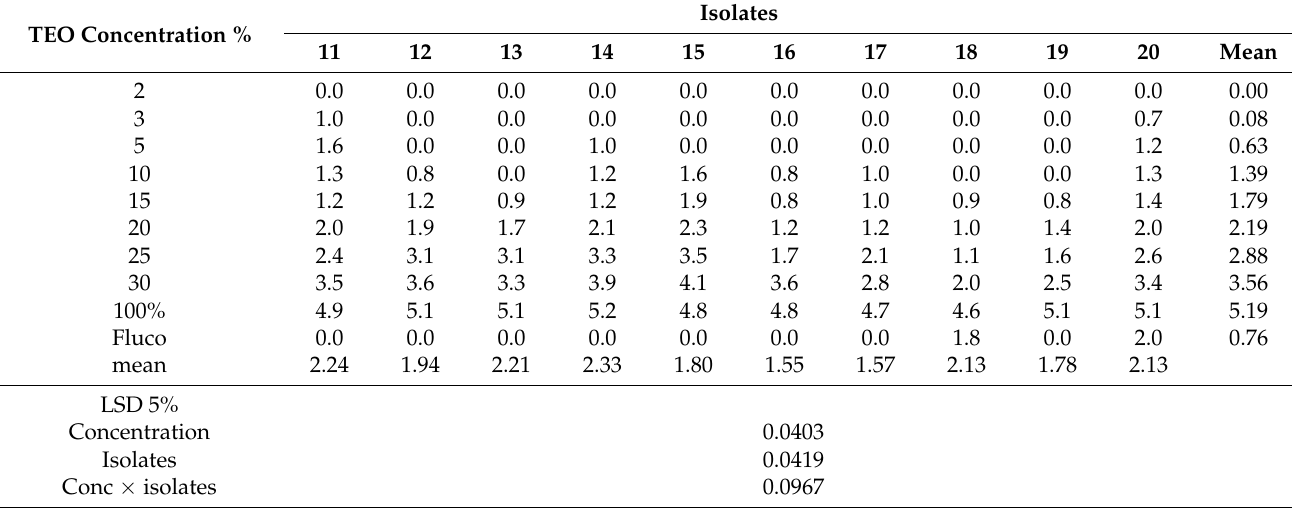
Table 4. Zone of inhibition (cm) of C. albicans isolates from blood at different concentrations of thyme essential oil (TEO). TEO Concentration